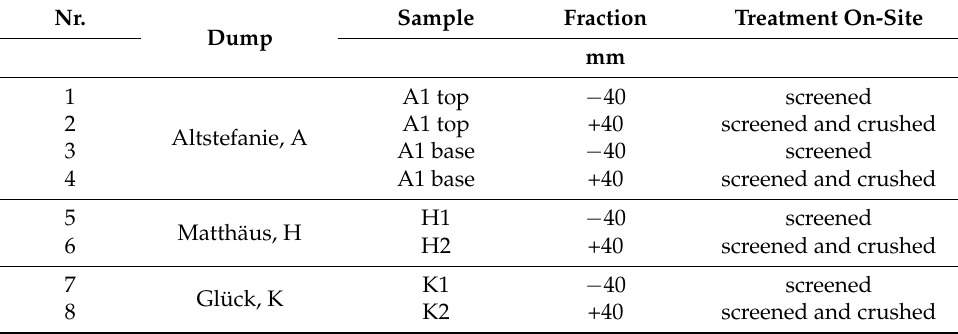
Table 1. A summary of the waste rock dump sample